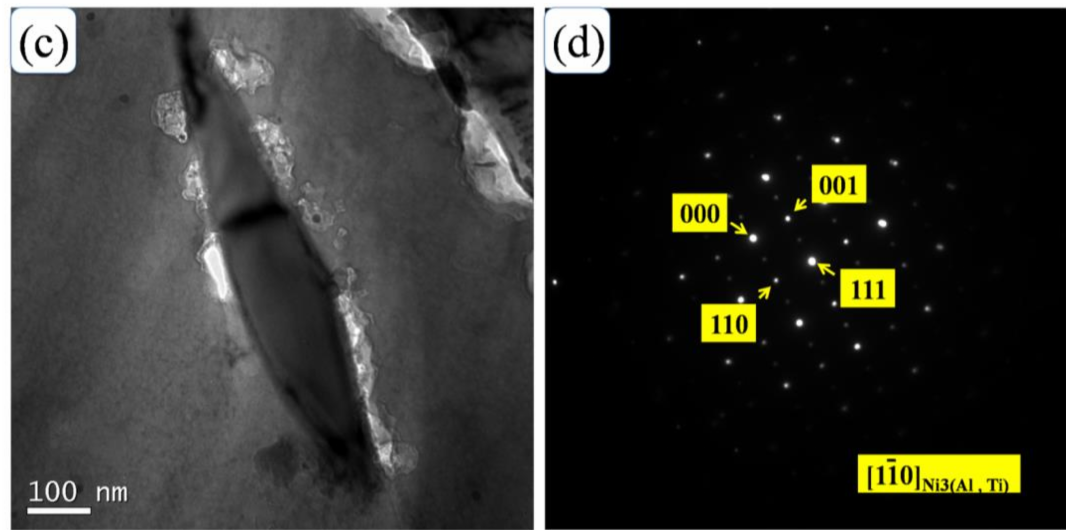
Figure 9. TEM micrographs of heat-treated Ni-Nb5 alloy: ( a ) Bright field image indicating γ matrix; ( b ) Diffraction pattern of ( a ); ( c ) Bright field image indicating Ni 3 (Al,Ti) phase; ( d ) Diffraction pattern of Ni 3 (Al,Ti) phase in ( c